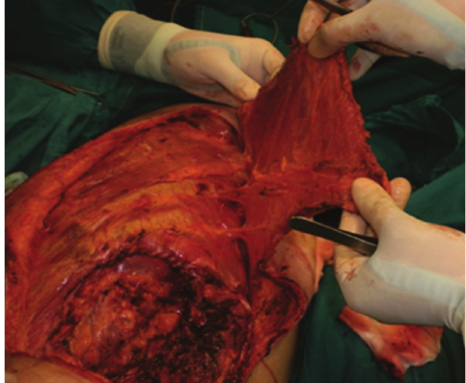
Figure 5: Exposure of the LD muscle.